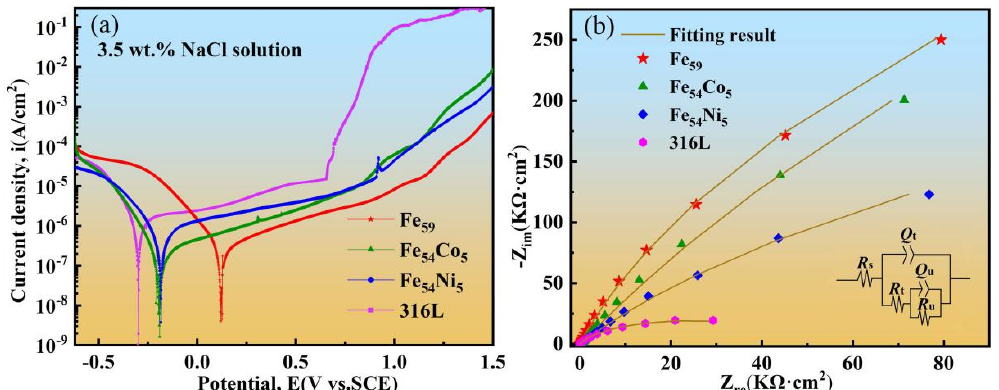
Figure 2. ( a ) Potentiodynamic polarization curves in 3.5 wt% NaCl solution at room temperature for Fe 54 M 5 Cr 15 Mo 6 Si 2 B 4 P 10 C 4 (M = Fe, Ni, and Co) glassy alloy rods and 316L stainless steel; ( b ) Nyquist plots and the corresponding equivalent circuit (inset) for fitting the impedance spectra of Fe 54 M 5 Cr 15 Mo 6 Si 2 B 4 P 10 C 4 (M = Fe, Co, and Ni) glassy alloy rods and 316L in 3.5 wt.% NaCl solution at room temperature.